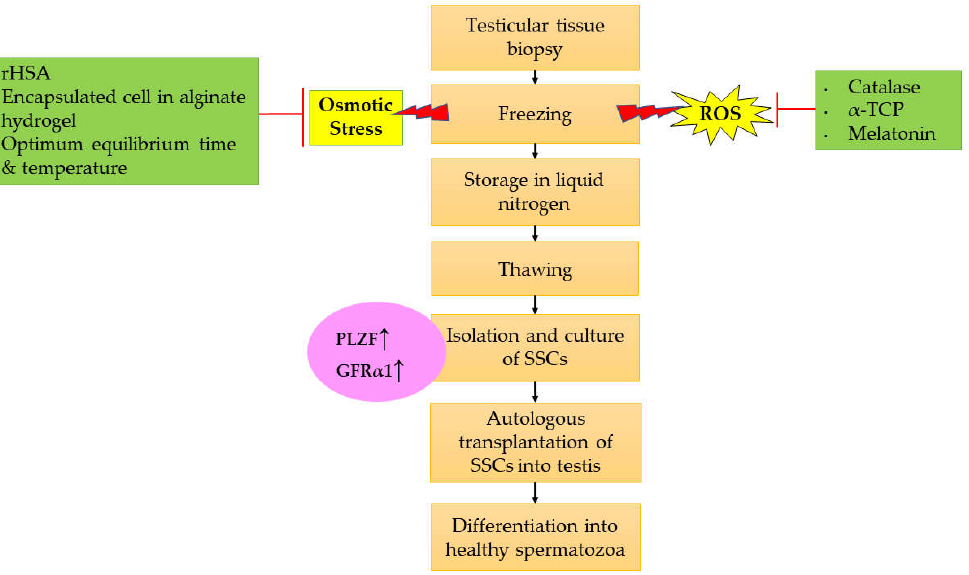
Figure 2. Therapeutic approach for improving the cryopreservation of SSCs via evaluating the expression of PLZF and GFRα1 as biomarkers. Abbreviation: ↑ Increase/enhance.